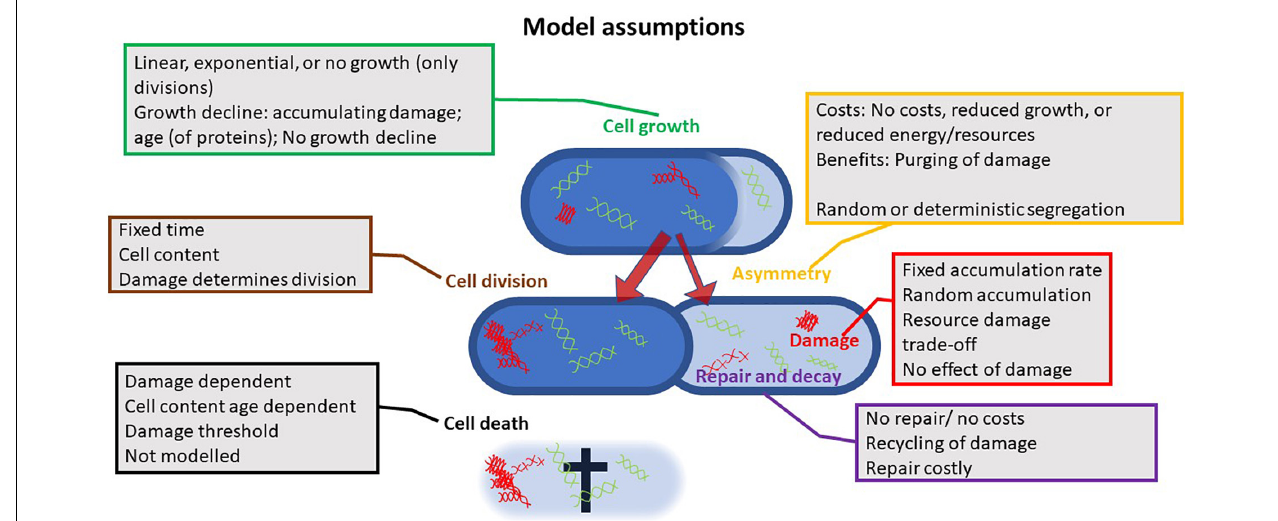
FIGURE 2 | Illustration of the assumptions different models rely on; all models investigated the effects of asymmetry at cell fission. The multitude of assumptions and combinations thereof highlights how contrasting findings can be explained. Up to six parameters have been considered in such models: growth or the increase in active proteins, cell division, damage accumulation or the rate at which active proteins are transformed into passive proteins, the asymmetry at fission in damage or passive proteins, the decay of damage or the repair for passive to active proteins, and cell death. Differences in assumed cost functions, efficiencies of repair, and effect of damage further increase the diversity of